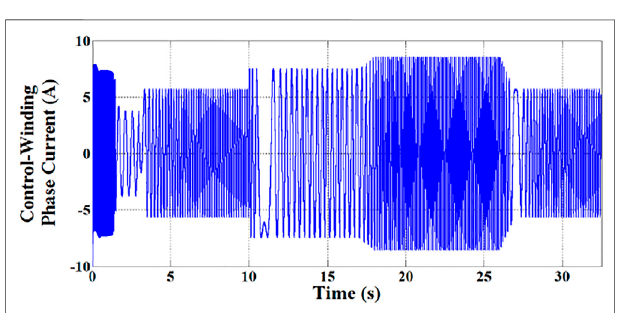
FIGURE 12 | Response of the control-winding phase-current.